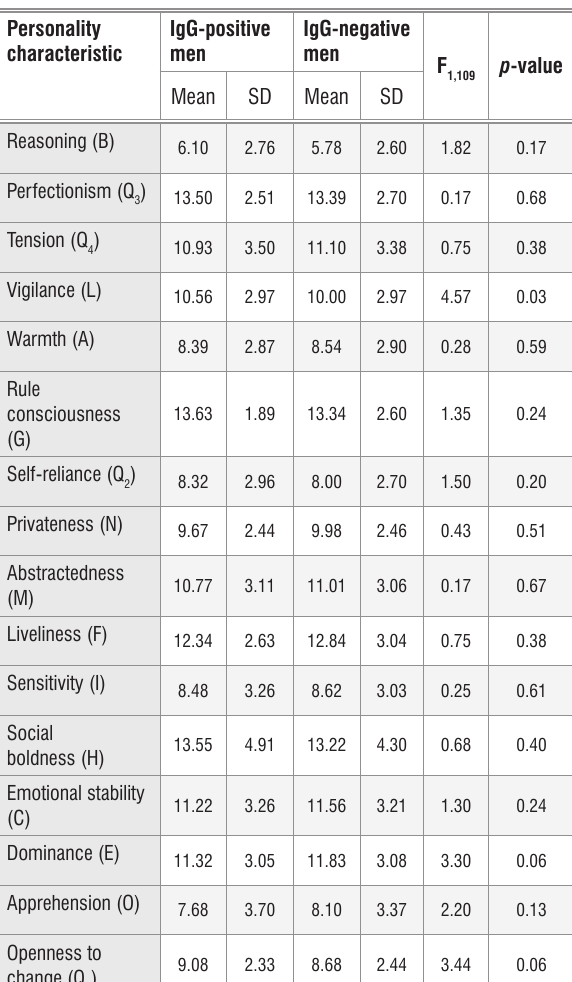
Comparison using multiple univariate ANOVA of personality characteristics in women according to seroprevalence